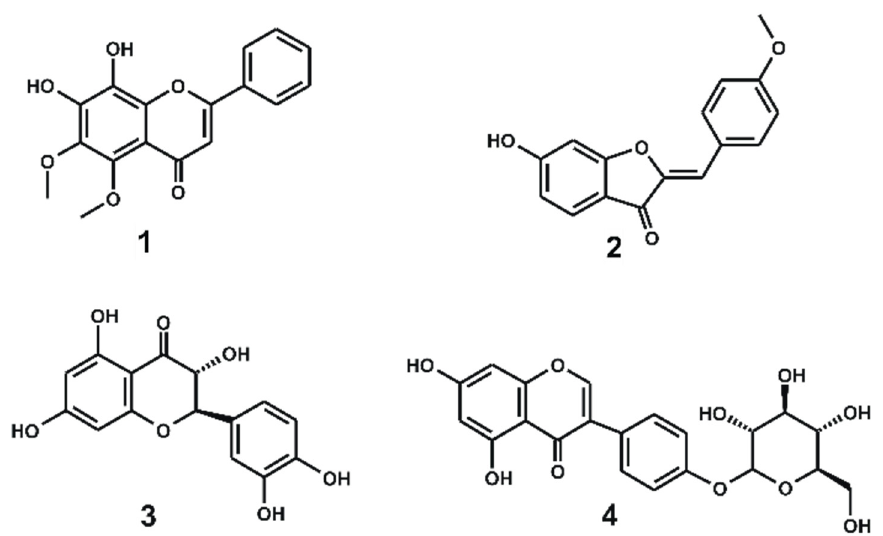
Figure 2. Chemical structures of the newly identified PIM1 inhibitors from natural plant sources.